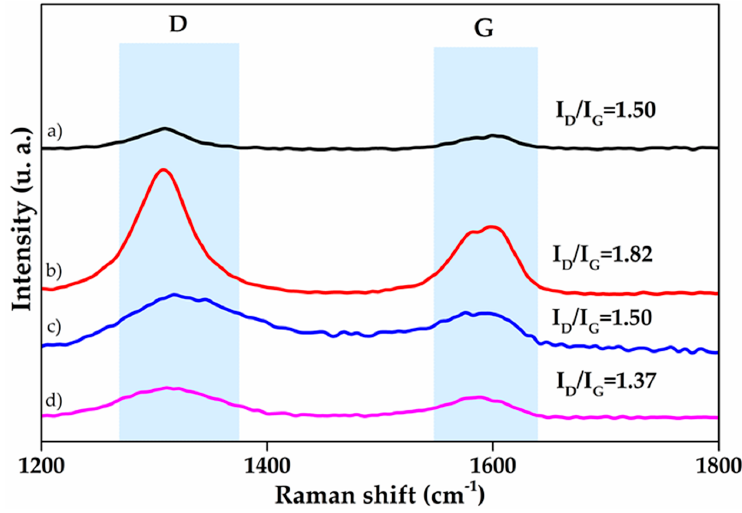
Figure 2. Raman signals of: ( a ) MWCNT; ( b ) O-MWCNT; ( c ) GO; and ( d ) RGO.